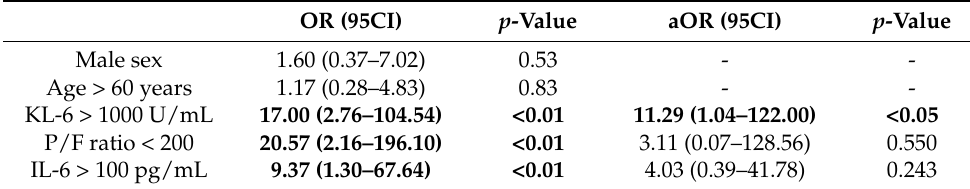
Table 6. Univariate and multivariate regression analysis for